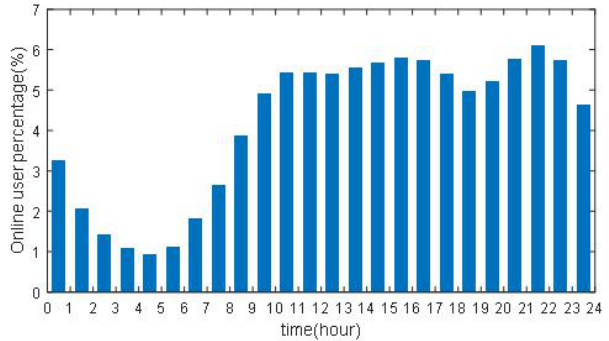
Figure 4. Internet users vs time of